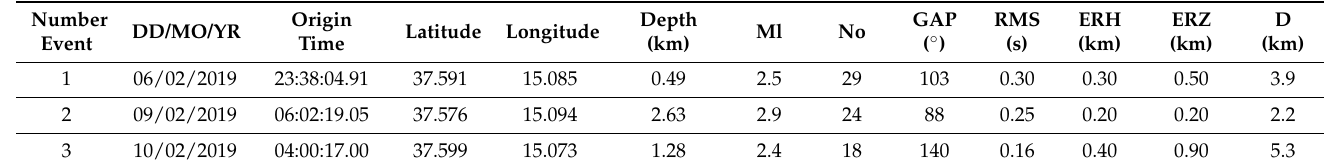
Table 1. Earthquakes occurring in February 2019 with main hypocentral location parameters.